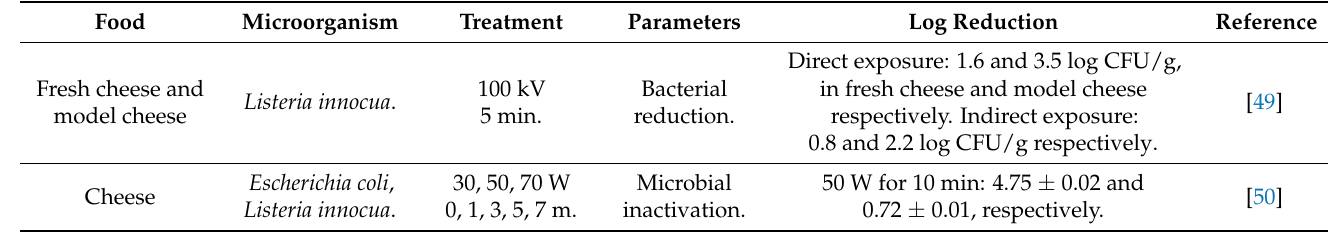
Table 3. Dairy products treated with DBD cold plasma at atmospheric pressure and ambient